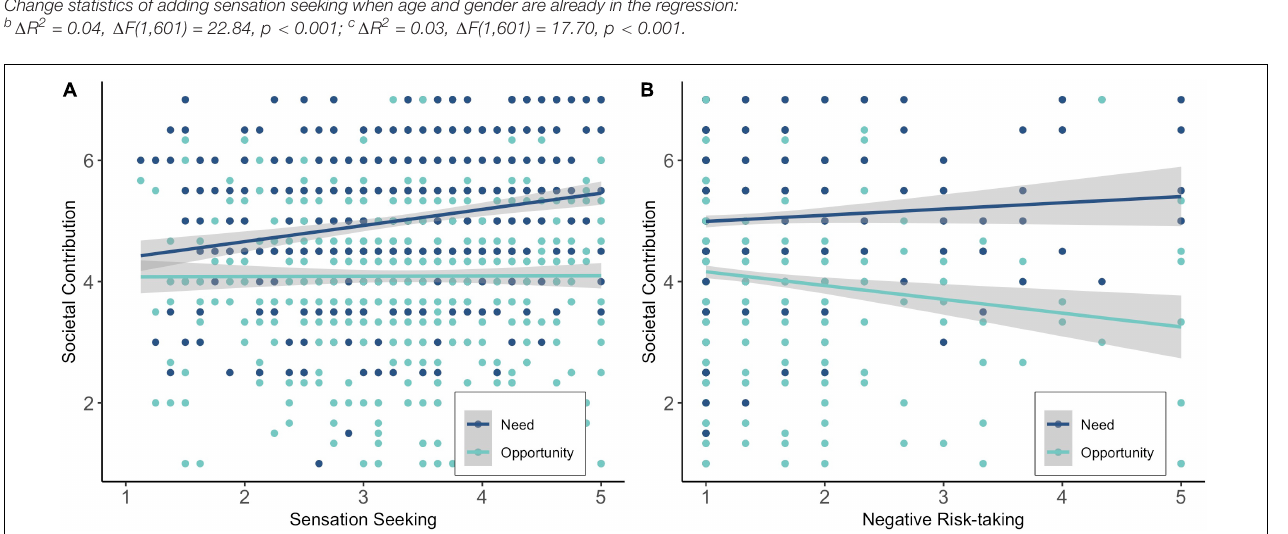
FIGURE 6 | Sensation seeking (A) and negative risk-taking (B) as predictors of the need to and opportunities of societal contribution during COVID-19.